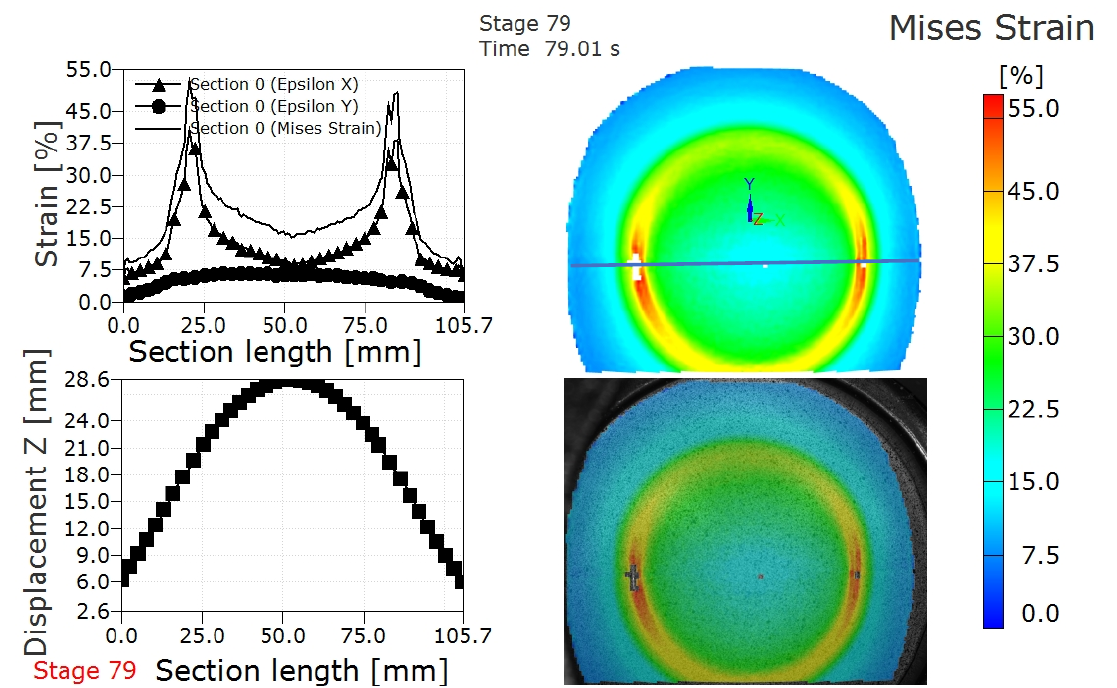
Figure 9. Strain distribution and displacement distribution along the path and Mises strain in the AA5754 tailor-welded blanks with thickness 2.2 mm after fracture.